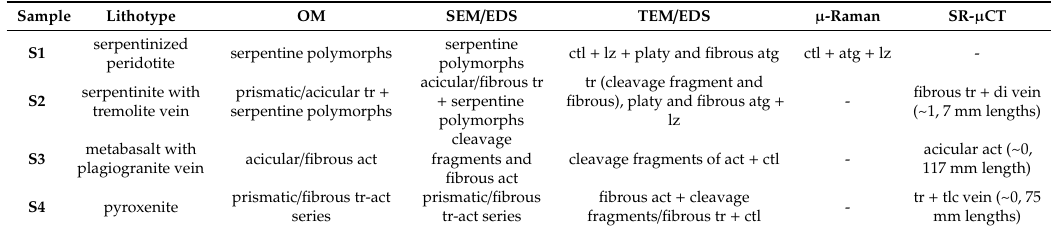
Table 1. Summary of asbestos minerals and their fibrous but non-asbestiform analogues with their relative morphologies identified with the di ff erent analytical techniques used, respectively: Optical Microscopy (OM); Scanning Electron Microscopy combined with Energy Dispersive Spectrometry (SEM / EDS); Transmission Electron Microscopy combined with Energy Dispersive Spectrometry (TEM / EDS); Micro-Raman spectroscopy ( µ -Raman); Synchrotron Radiation X-ray Microtomography (SR- µ CT). Mineral name abbreviations are according to [36].